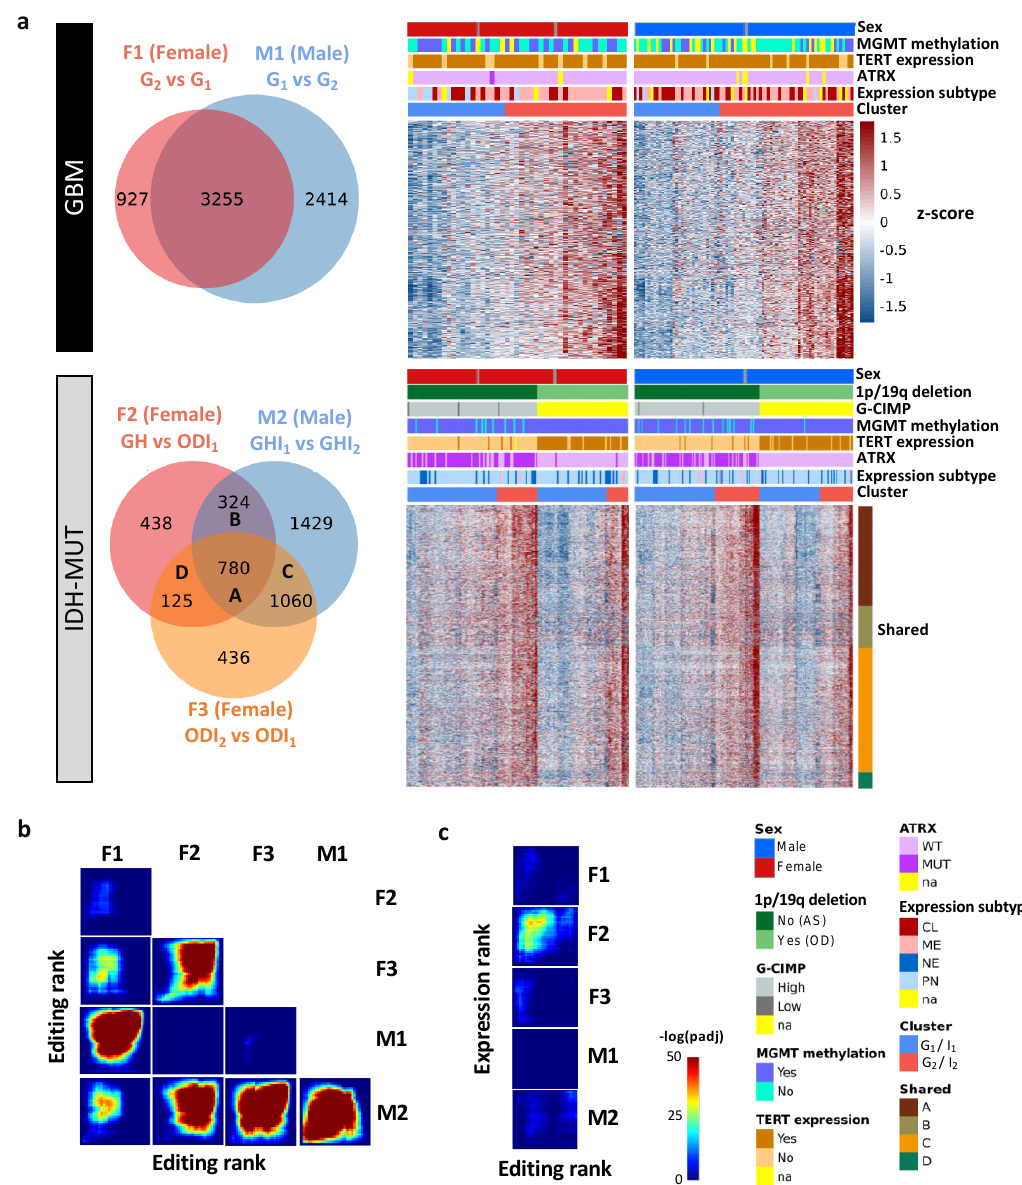
Figure 3. Editing changes during glioma progression. ( a ) Venn diagram and editing levels of differentially edited sites (DESs) between high- and low-risk gliomas. Comparisons are made for GBM (F1: G 2 vs G 1 and M1: G 1 vs G 2 ) and IDH-MUT gliomas (F2: GH vs ODI 1 ; F3: ODI 2 vs ODI 1 and M2: GHI 1 vs GHI 2 ). GH: astrocytoma with high levels of DNA methylation; OD: oligodendroglioma. ( b ) Overlap in genes with DESs between sexes and between comparisons. ( c ) Overlap between genes with DESs and those with differential expression in the five comparisons.